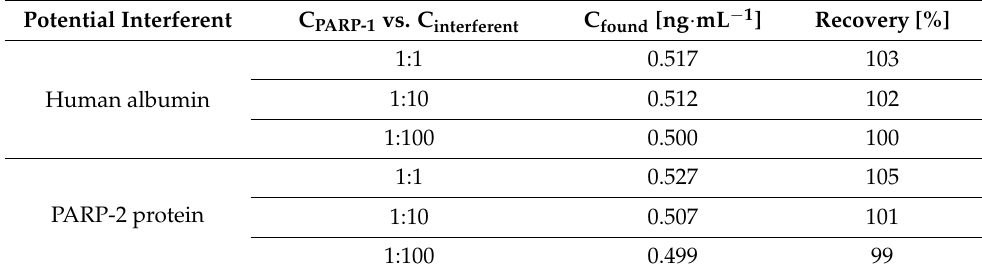
Table 2. Selectivity of the investigated method of PARP-1 determination.